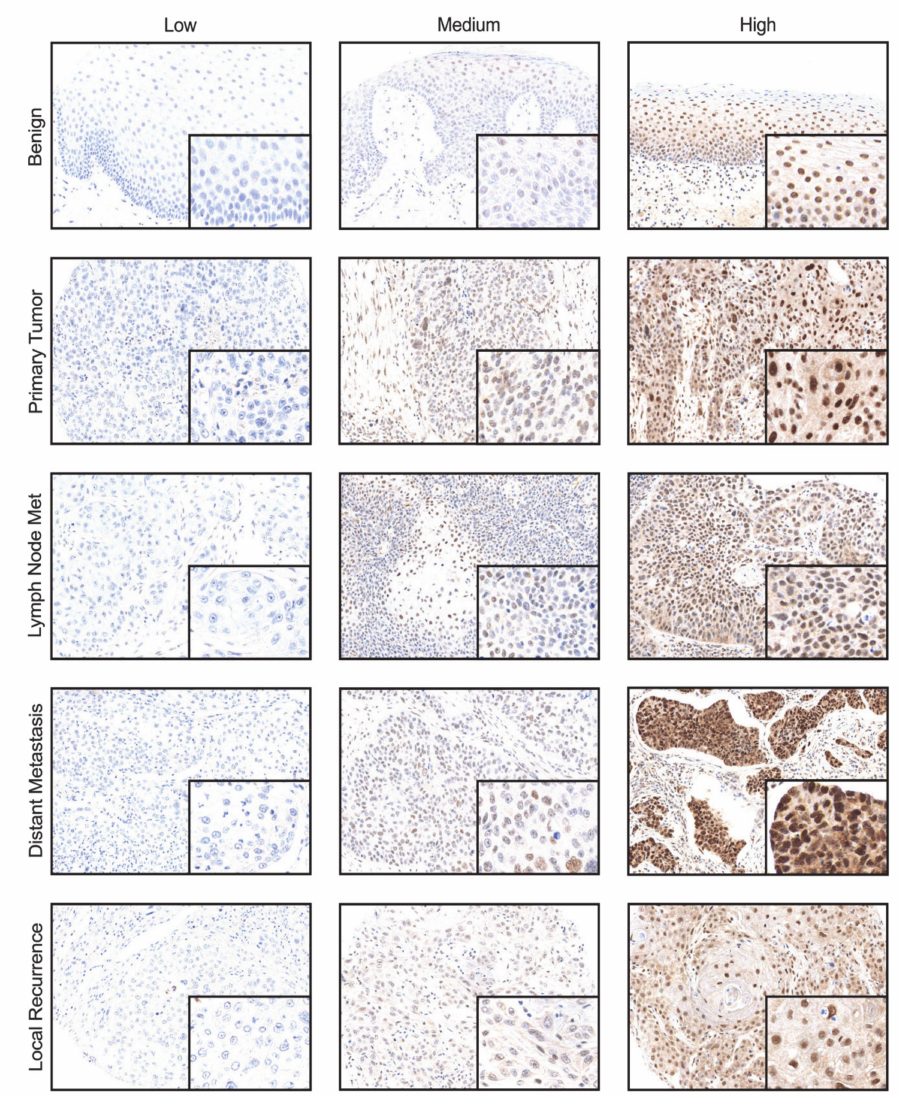
Figure 1. Representative IHC images showing low, medium, and high nuclear CDK19 expression in benign squamous epithelial tissue of the head and neck area, primary tumors, lymph node metastasis, distant metastasis, and local recurrence (10 × magnification, insert 40 ×